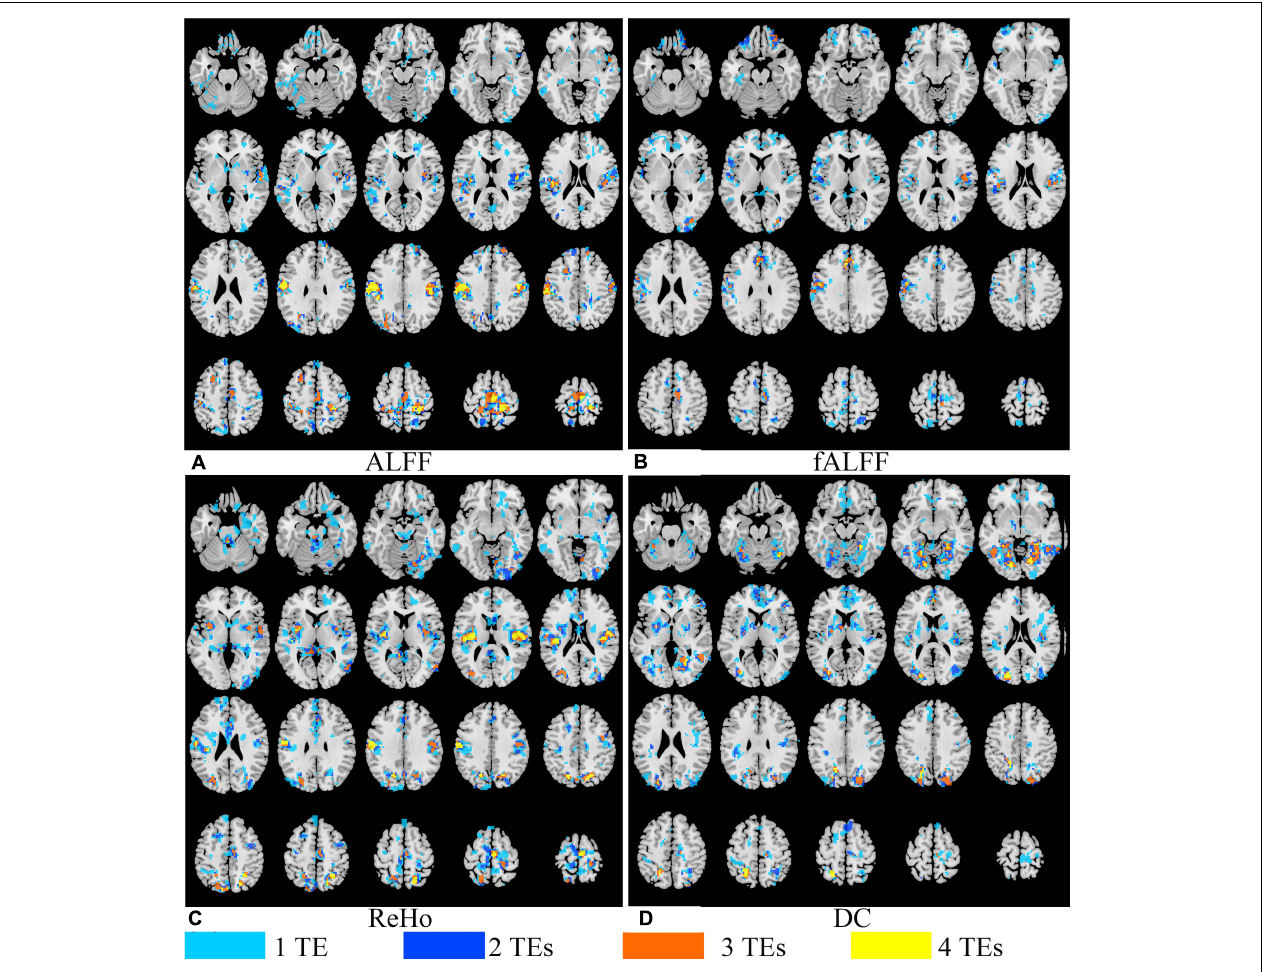
FIGURE 7 | The overlap of paired T maps of between EO and EC from four different TE datasets for ALFF (A) , fALFF (B) , ReHo (C) , and DC (D) . “1 TE” means any one of the four echoes, “2 TEs” means any two of the four echoes, “3 TEs” means any three of the four echoes, and “4 TEs” means all the four echoes. EO, eyes open; EC, eyes closed; ALFF, amplitude of low-frequency fluctuation; fALFF, fractional ALFF; ReHo, regional homogeneity; DC, degree centrality.